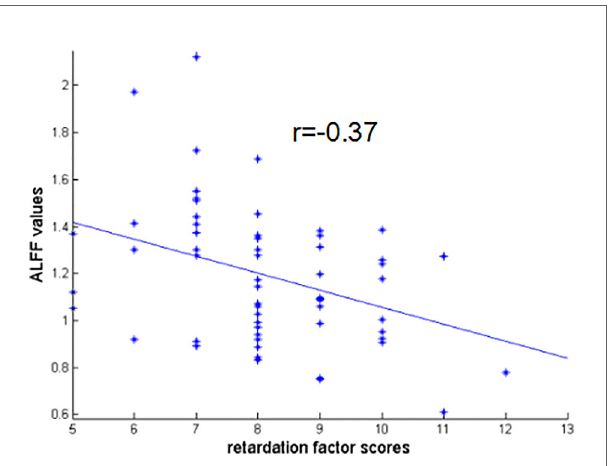
FIGURE 5 | Negative correlation between the ALFF values of RO-MFG in AD group with retardation factor scores (r = – 0.37, p = 0.003). ALFF, amplitude of low-frequency fl uctuation; AD, anxious depression; RO-MFG, right orbital part of middle frontal